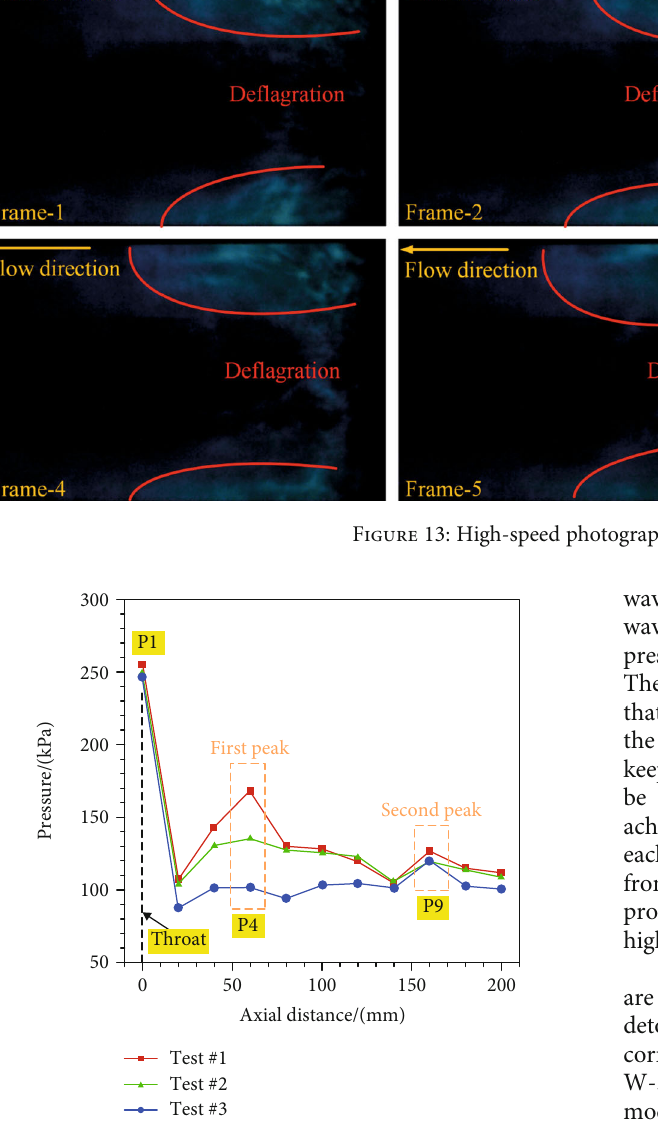
Figure 14: Pressure-distance distribution of Test